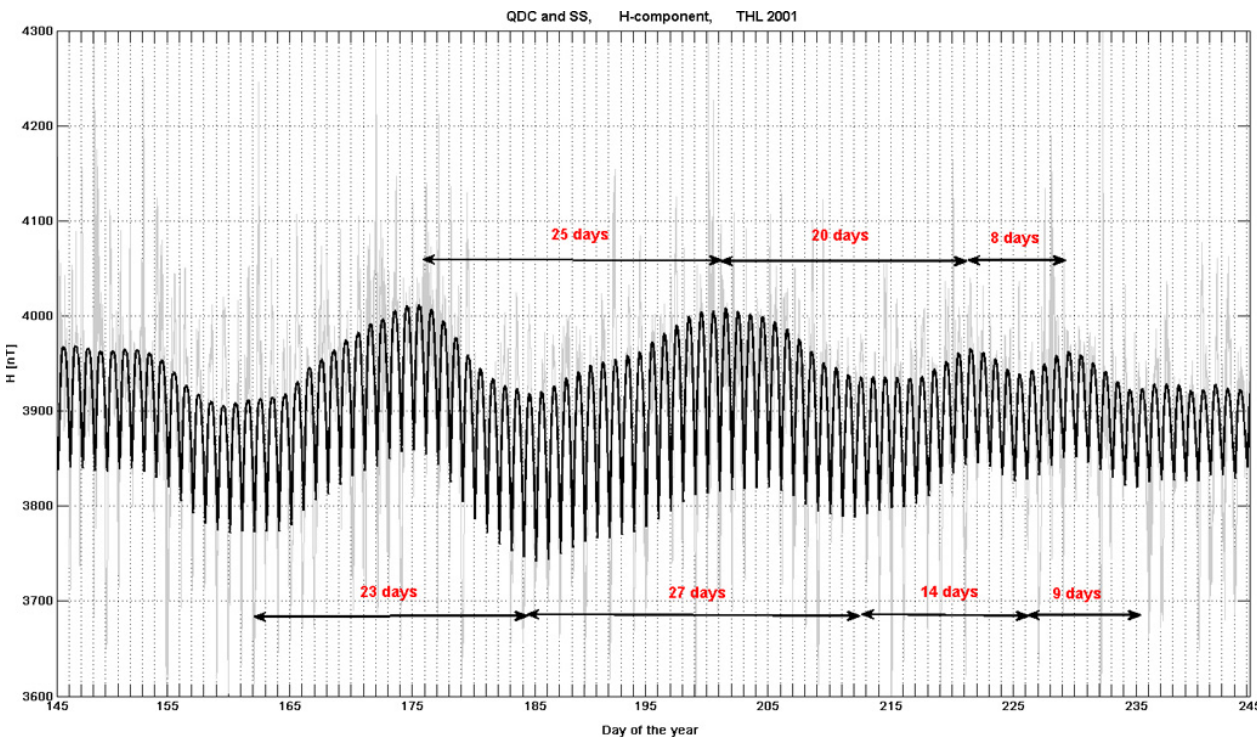
Fig. 1. Superposition of the actual variation of 1-min values of the geomagnetic H-component observed at Thule station in the summer season of 2001 (thin lines) and the quiet daily curve (QDC) characterizing the daily variation of the quiet geomagnetic field (thick solid